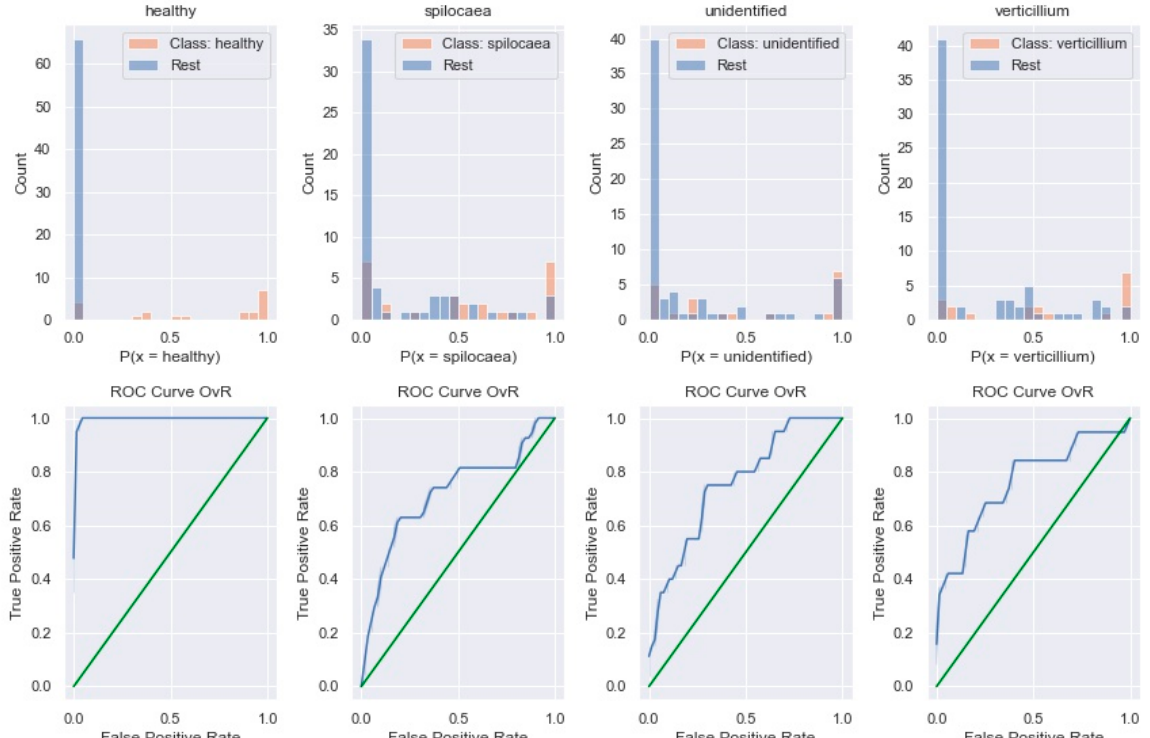
Figure 11. One-vs.-rest binary classification probabilities for each class and “Rest” pair ( top ), and the accompanying ROC plots for each pair ( bottom ) used as an evaluation overview. The green lines represent a 1:1 True Positive to False Positive ratio for a model with 0.5 AUROC. The blue lines represent the True Positive to False Positive ratio for each class comparison with the “Rest”.